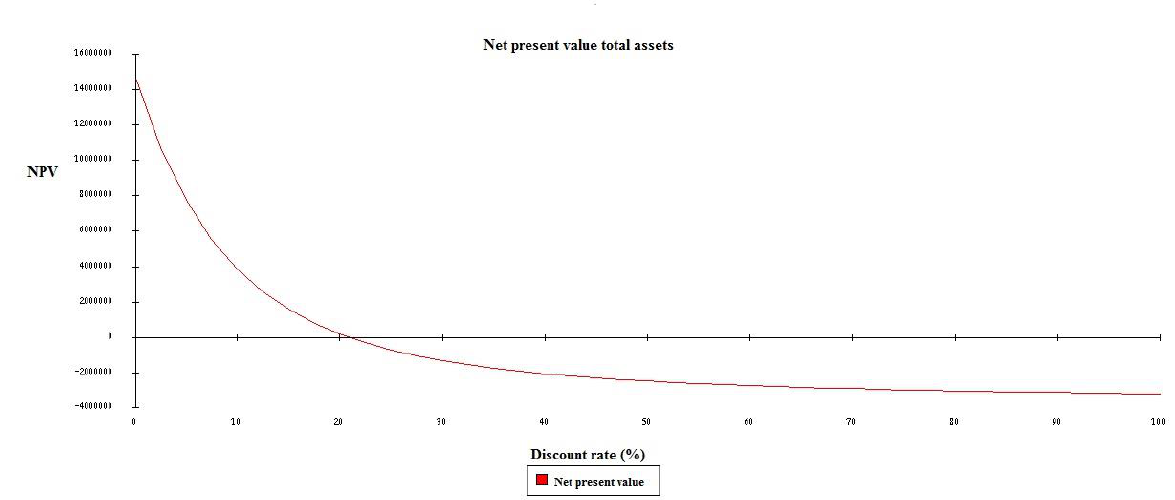
Figure 3. Total Capital NPV (per one-tenth dollar)